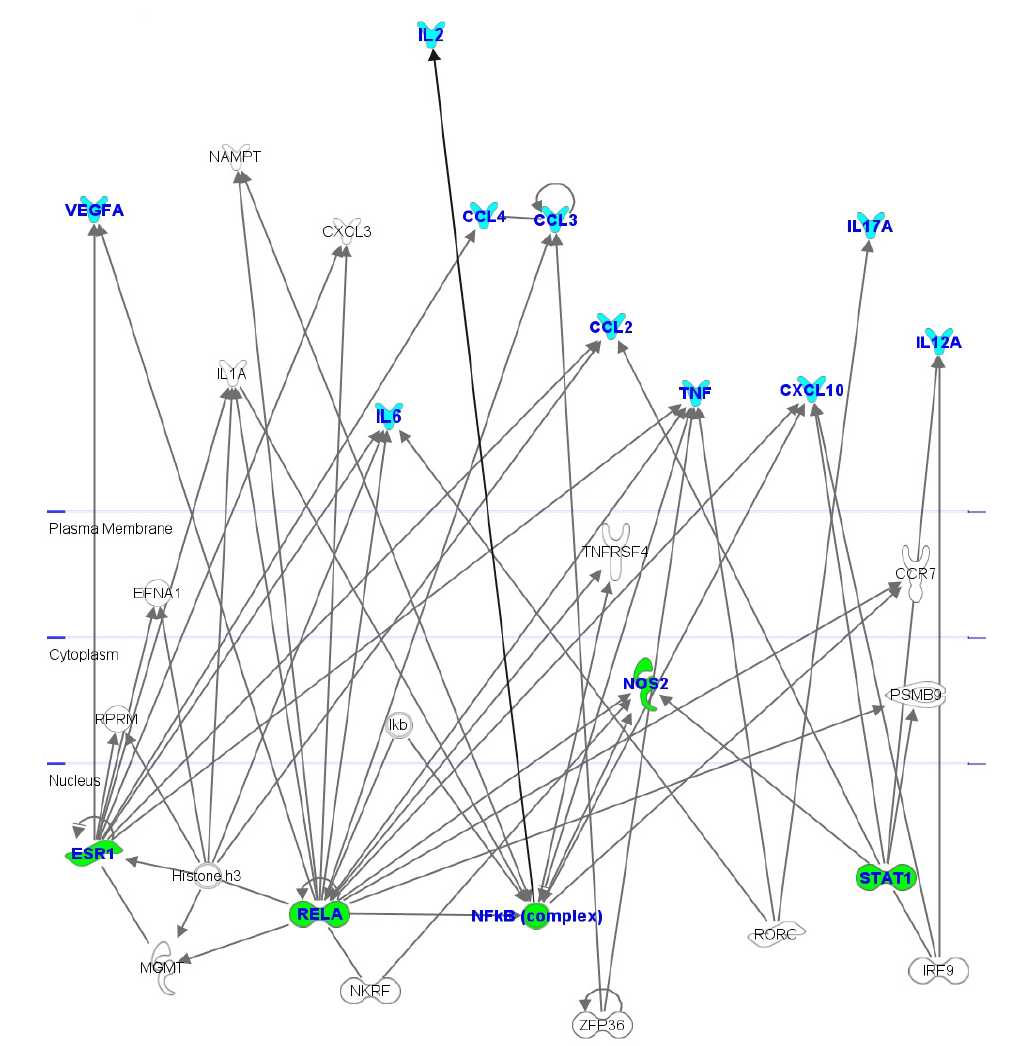
Figure 5. Interactomic analysis by Ingenuity Pathway Analysis (IPA) of significant molecules. The interactome shows the close functional association between significant cytokines (evidenced with cyan symbols) as well as the paths in which other functionally relevant molecules are also involved (evidenced with white symbols). In particular, some hub node (ESR1, NF-kB, NOS2, RELA subunit, and STAT1) are evidenced by green